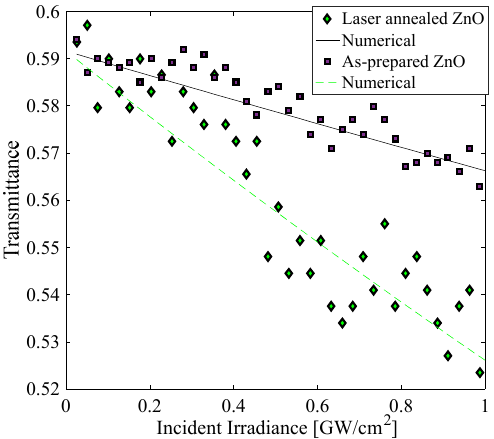
Figure 1. Evolution of the optical transmittance as a function of the incident irradiance in the samples studied by nanosecond pulses at 532 nm in a single-beam configuration.